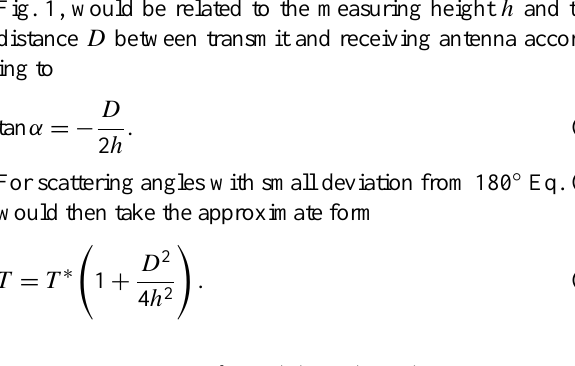
Figure2:Real(thi kline)andmodeled(thinline)Gaussianapertureilluminationfun tionwithstandarddeviation a e .11